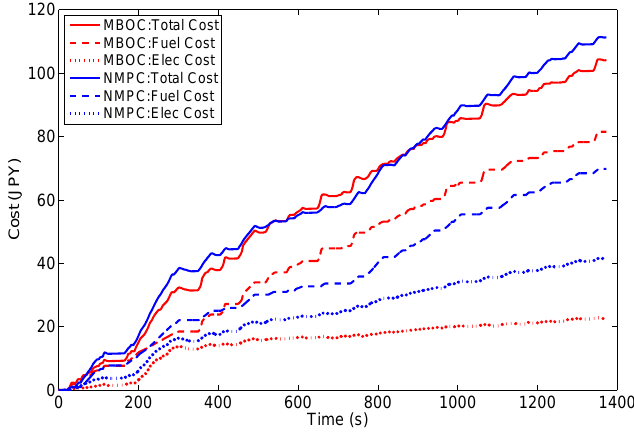
Figure 11. Cost for MBOC and NMPC strategies in ζ = 0 . 82 .